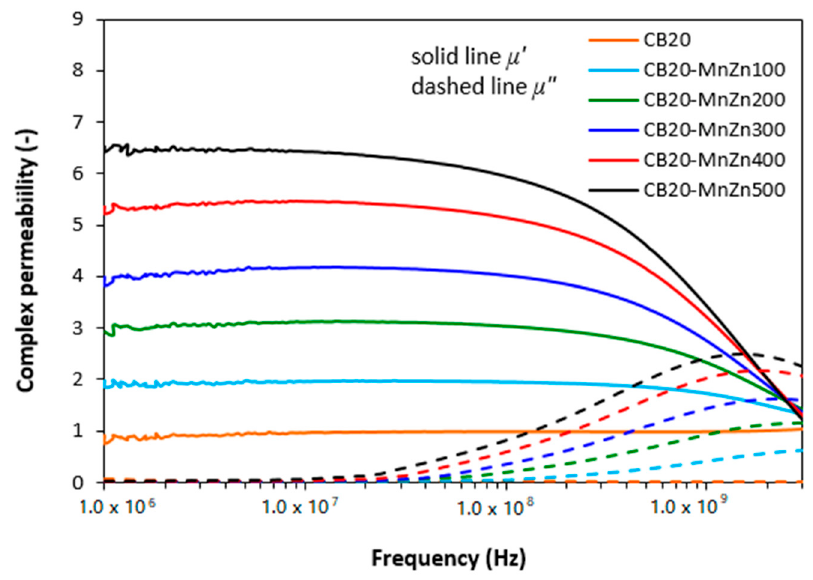
Figure 4. Frequency dependences of real ε′ and imaginary ε″ parts of complex permeability for hybrid CB/ferrite filled composites.